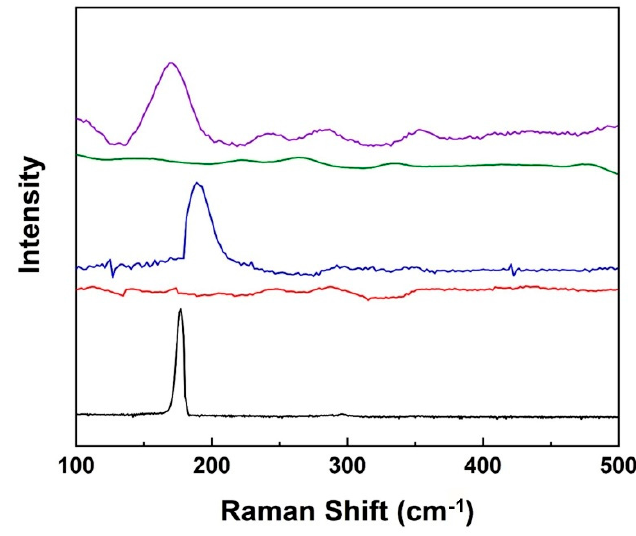
Figure 4. Raman spectra of solid I 2 (black), activated UiO-66 (blue), I 2 -loaded UiO-66 (red), activated UiO-66-FA (green) and I 2 -loaded UiO-66-FA (purple). The complete spectra are shown in Figure S5.